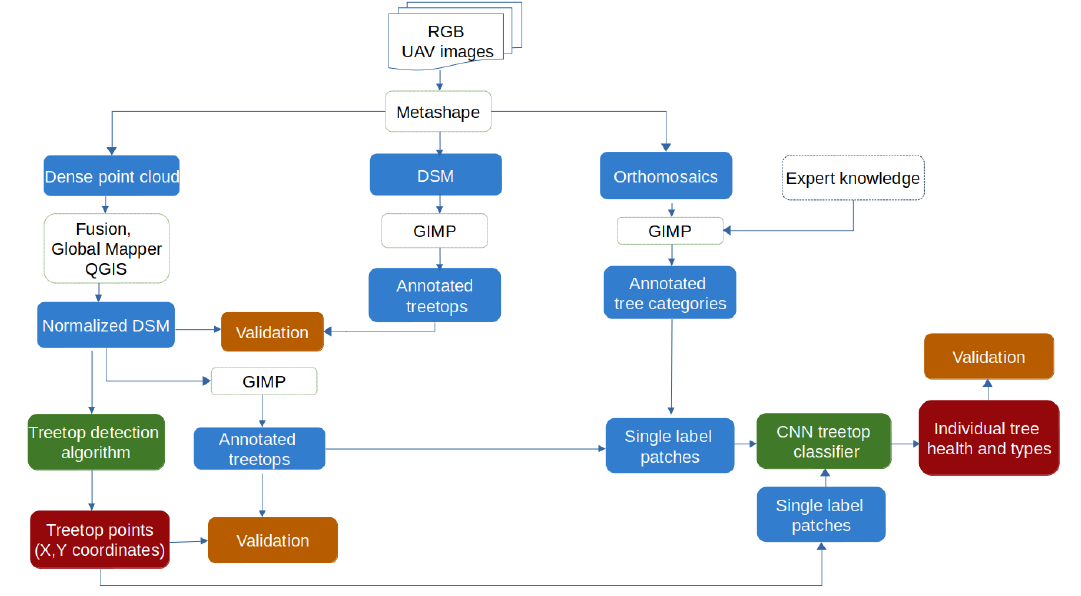
Figure 3. Algorithm pipeline used in this study. Blue, processed data in different formats. White with dash green border, external software used. Dark Green, algorithms developed as part of our study. Red, results of algorithms. Orange, validation